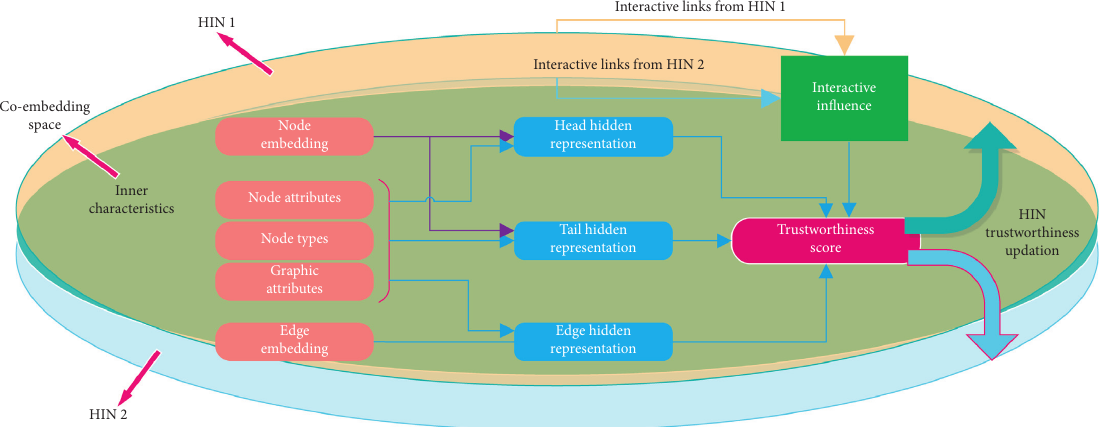
Figure 2: General structure of multi-HIN trustworthiness evaluation